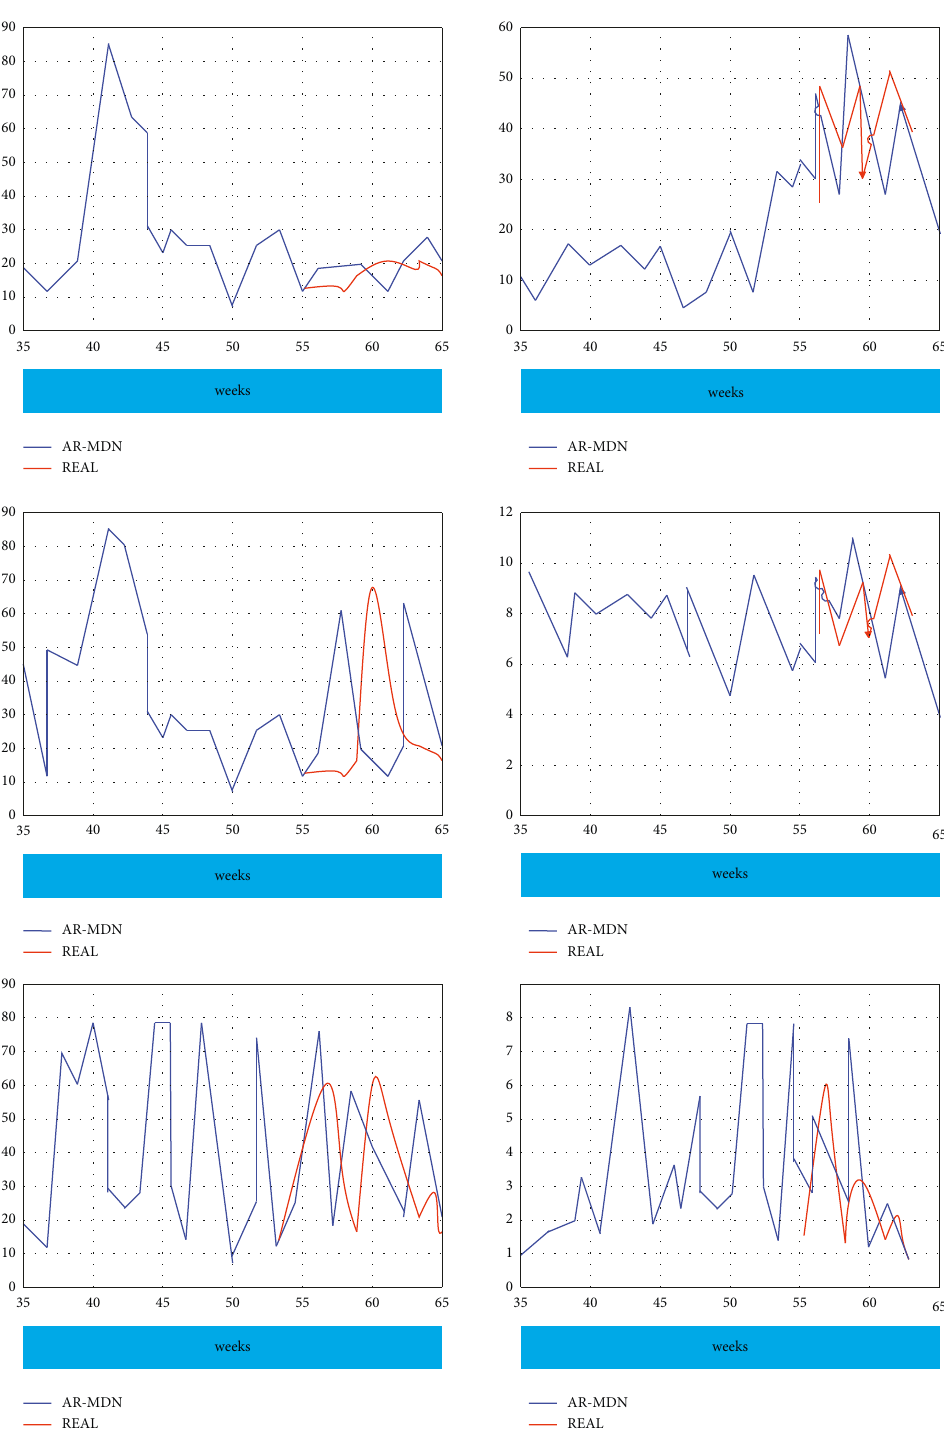
Figure 12: Comparison of prediction results for short-term demand of